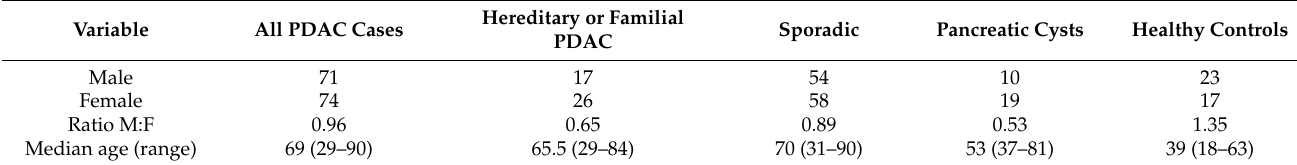
Table 1. Age and sex distribution of the individuals included in the study, according to the different groups analyzed pancreatic ductal adenocarcinoma (PDAC) cases (familial or hereditary (H/FPC) and Sporadic PDAC), pancreatic cysts and healthy